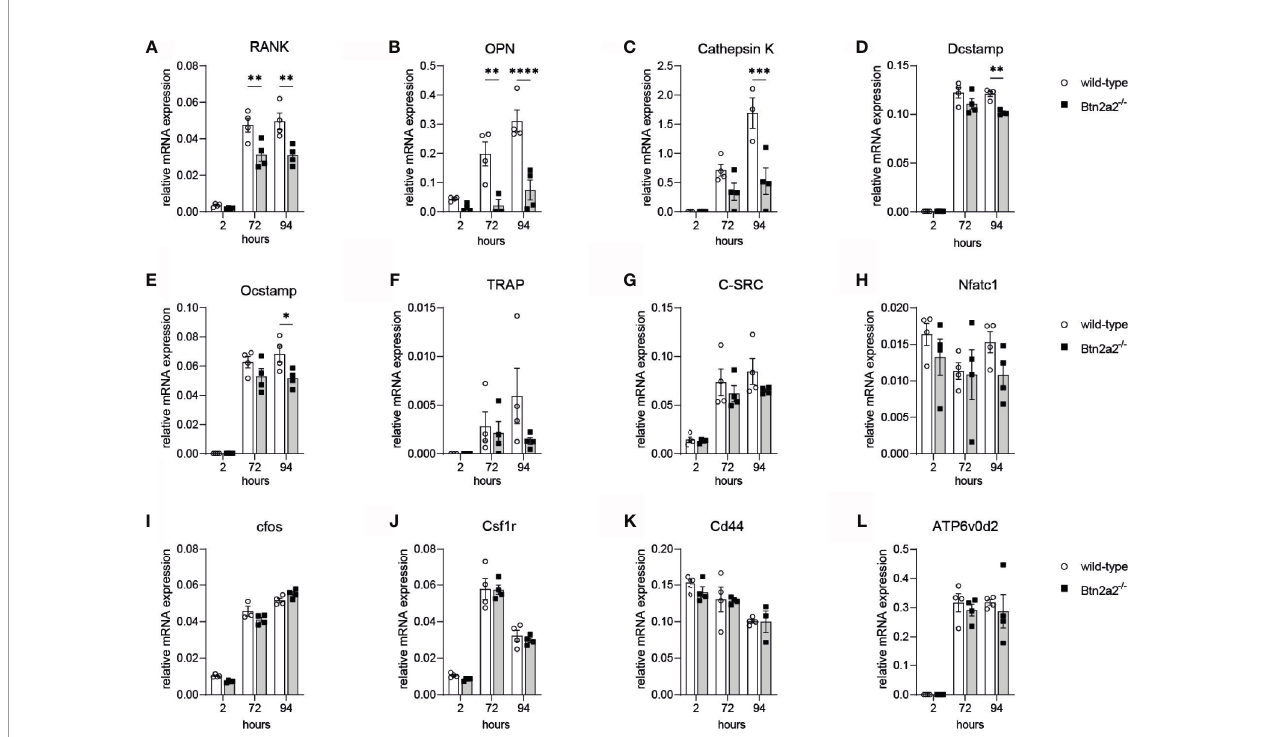
FIGURE 2 | Btn2a2-/- Osteoclasis reveal altered expression of OC-speci fi c transcriptional signature during osteoclastogenesis. (A – L) Expression of osteoclast- related genes in wild-type and Btn2a2' osteoclasts after stimulation of osteoclast precursors with RANKL (50 ng/ml)for the indicated time points. Relative expression values normalized to the housekeeping gene GAPDH are shown. Data are representative of two Independent experiments, with 3 mice per group. Signi fi cance was assessed using two-way ANOVAand Bonferroni's post-hoc test. Data are shown as means :t SEM. *P < 0.05; **P < 0.01; ***P < 0.001; ****p <